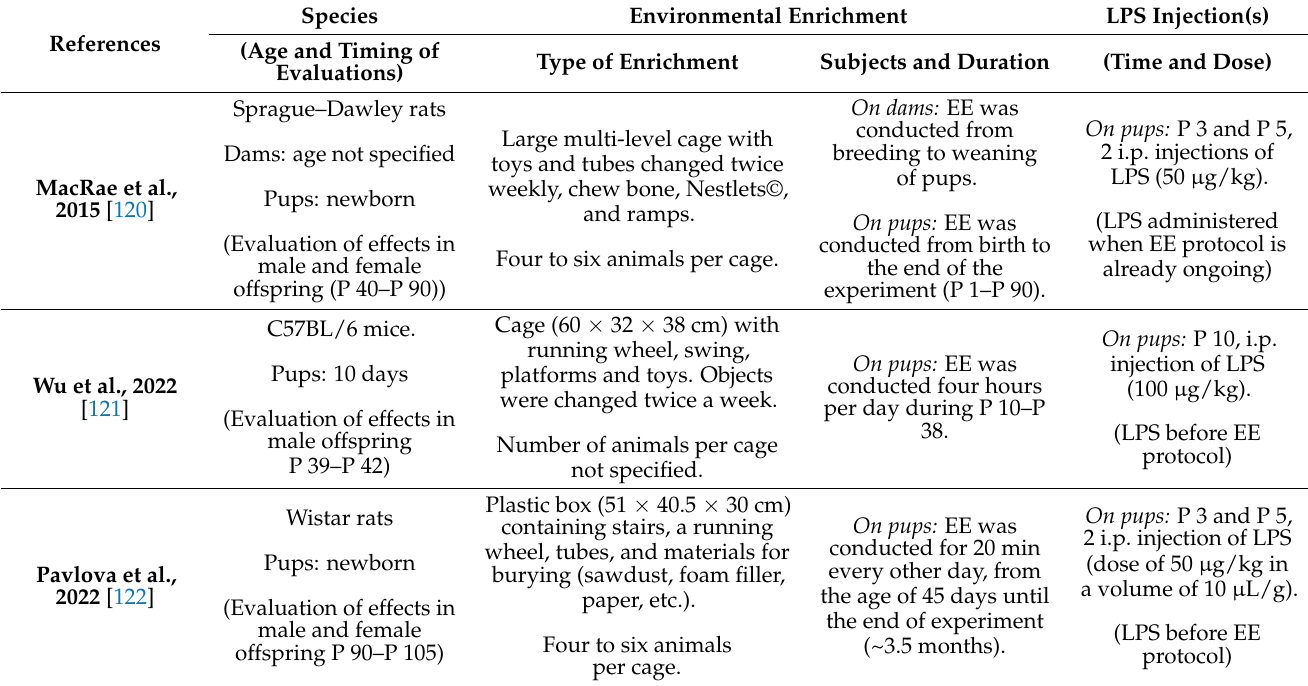
Table 3. Early postnatal inflammation—study